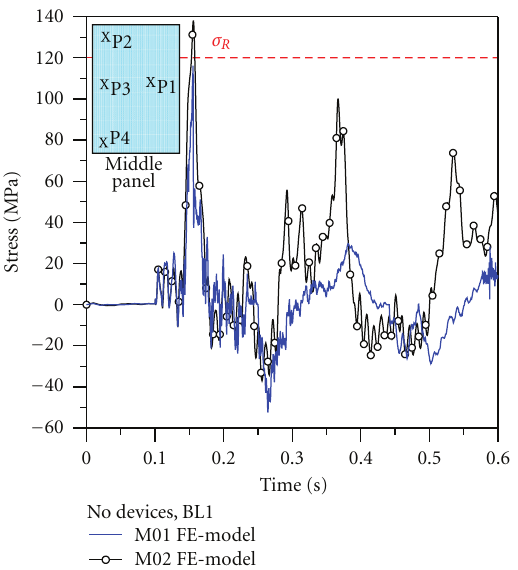
Figure 11: Comparison of maximum tensile stresses at location P1, as a function of time (ABAQUS). No devices. M01 and M02 FE- models, BL1.